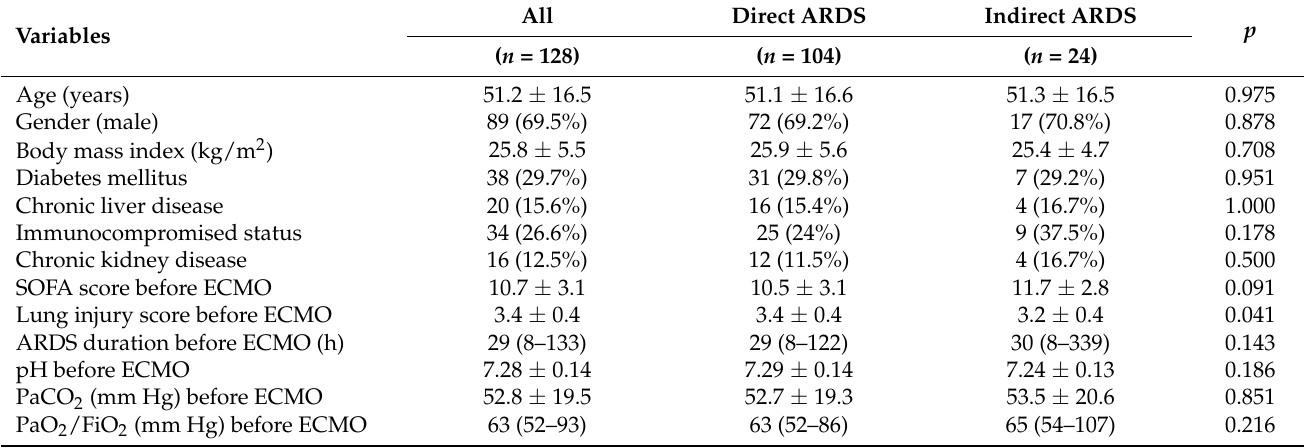
Table 5. Background characteristics and clinical variables after excluding VA ECMO patients: Direct and indirect ARDS